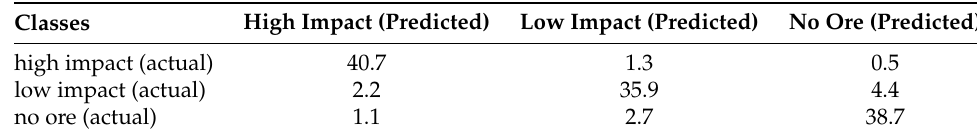
Table 7. Mean confusion matrix of the environmental impact classification model for 10-fold cross validation.